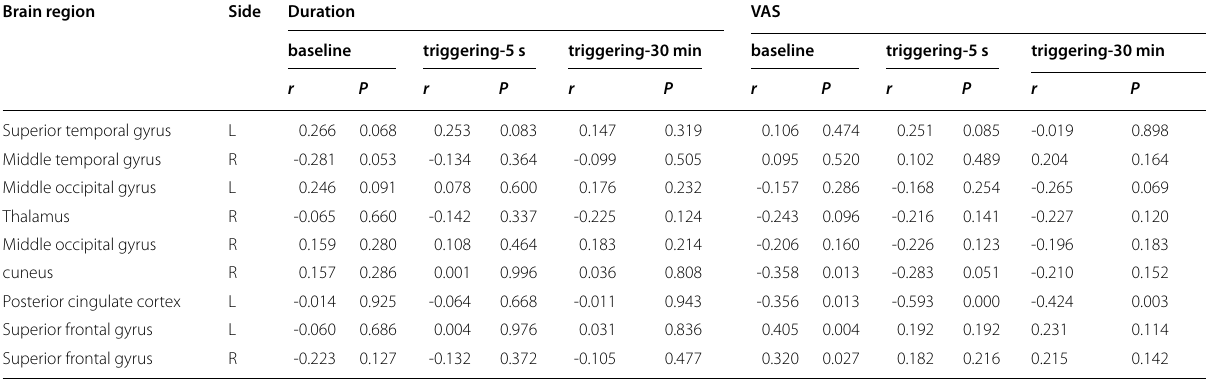
The correlation between the average dALFF values